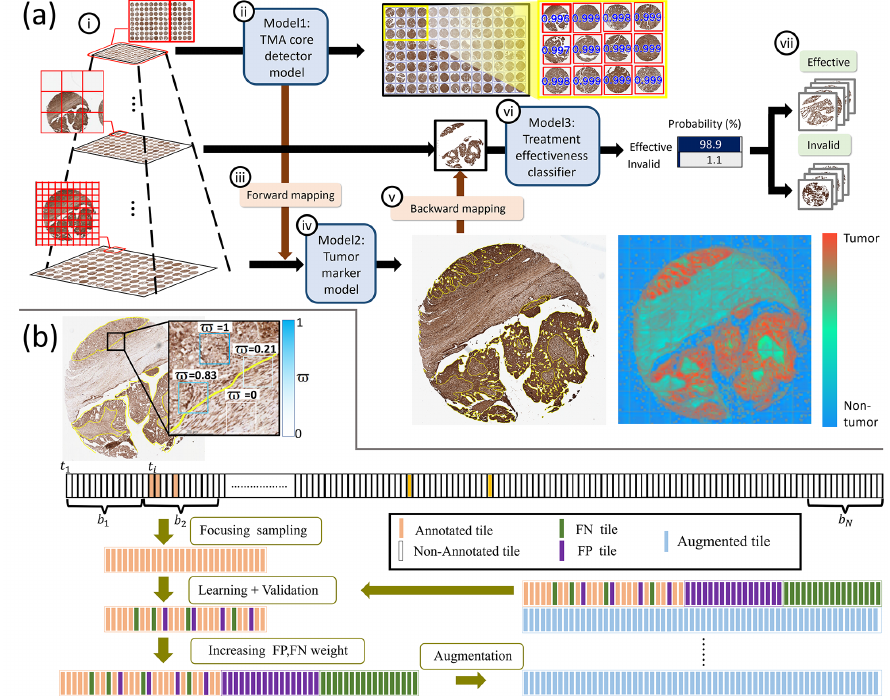
Figure 2. ( a ) System workflow: (i) multiresolution pyramid data structure of WSIs; (ii) a TMA core detection model conducts fast localization of tissue cores in low-resolution level; (iii) a forward- mapping function is applied to fetch the high resolution core data to be processed by (iv) a robust tumorlike tissue selection model to locate tumorlike tissues of each core; (v) a backward-mapping function is applied to fetch the medium resolution tumorlike tissue data of each core to be processed by; (vi) a treatment effectiveness classification model to predict; (vii) treatment outcomes; ( b ) Weakly supervised learning with focusing sampling, boosting learning and boosted data